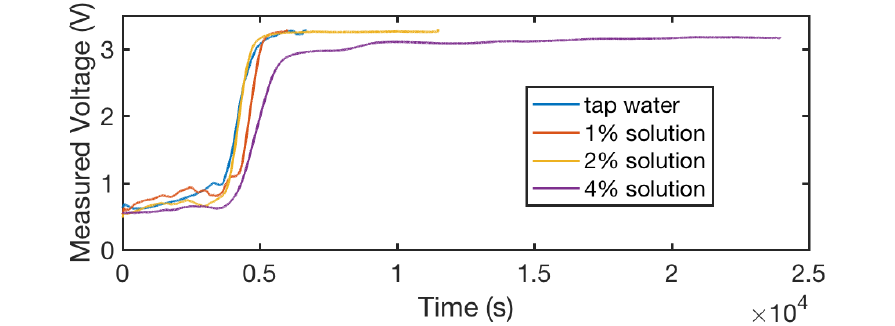
Figure 14. Thread readings during the evaporation process, with a five-point moving average applied. We observed that, for different solution densities below 4%, the sensor shows similar profiling through